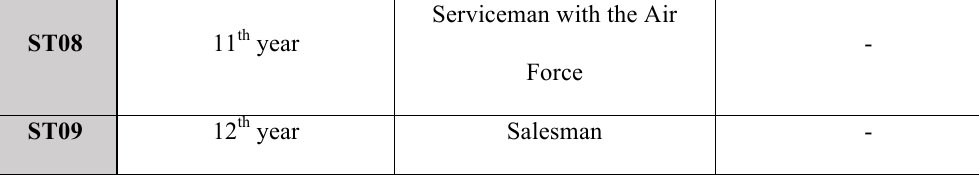
Table 2 . Characteristics of